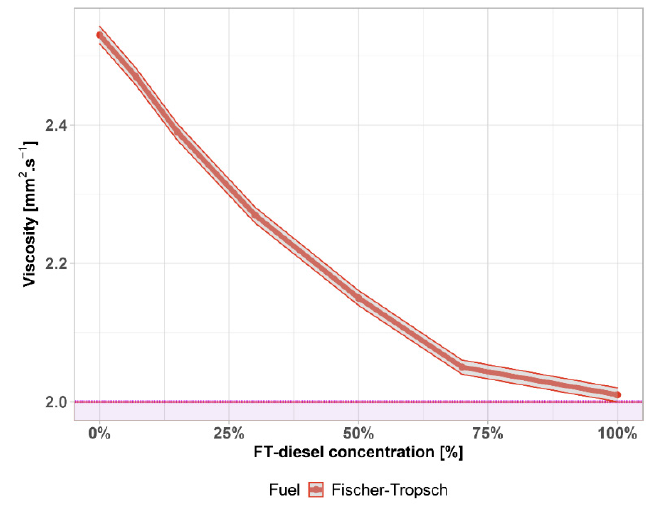
Figure 7. Viscosity of FT-diesel mixtures.